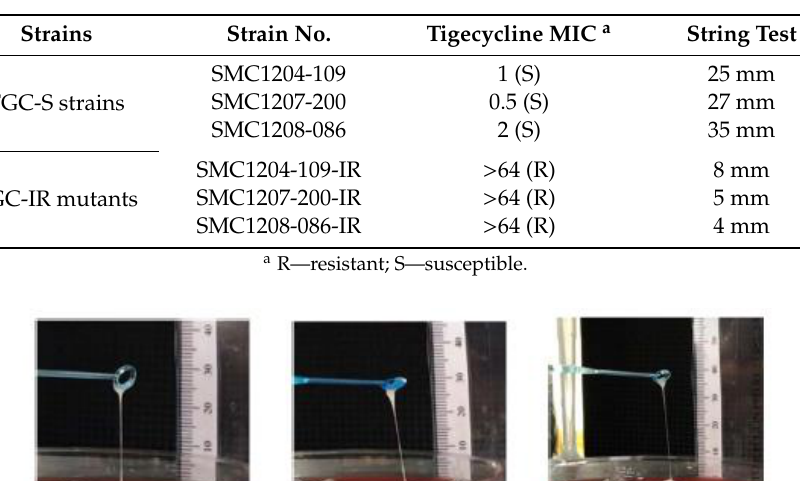
Table 1. Tigecycline minimum inhibitory concentrations (MICs) and the results of the string test in Klebsiella pneumoniae strains used in this study.